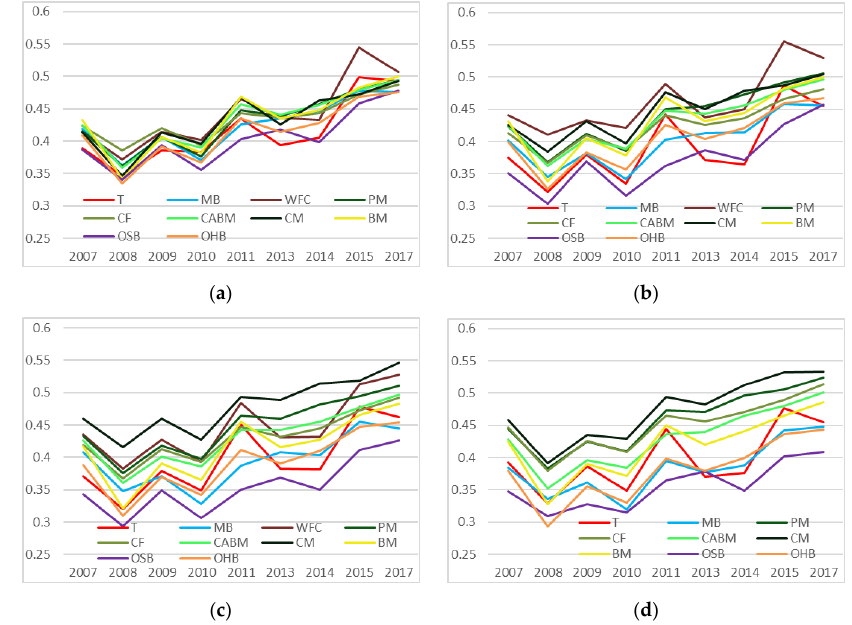
Figure 11. Broken-line graph showing EVI changes for 10 forest types, from 2007 to 2017, in typical slope zones: ( a ) 10 – 15°; ( b ) 15 – 20°; ( c ) 20 – 25°; and ( d ) 25 – 30°. Table 10. Disaster-impact-analysis results for different forest types in four slope zones.